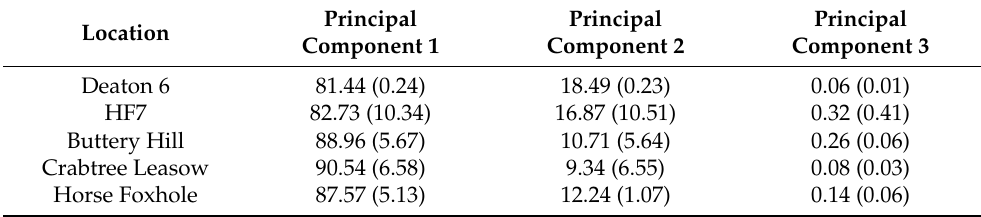
Table 4. The mean and standard deviations (in parentheses) of the percentage of variance are explained by the first three principal components of the satellite imagery time series at each sampling point at five locations.